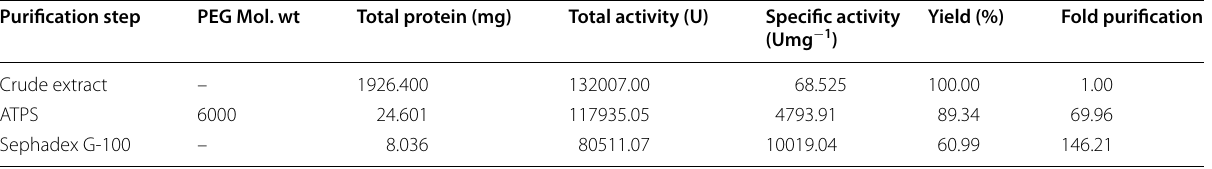
Table 3 Aqueous two-phase system (ATPS) purification of Fusant-06 l